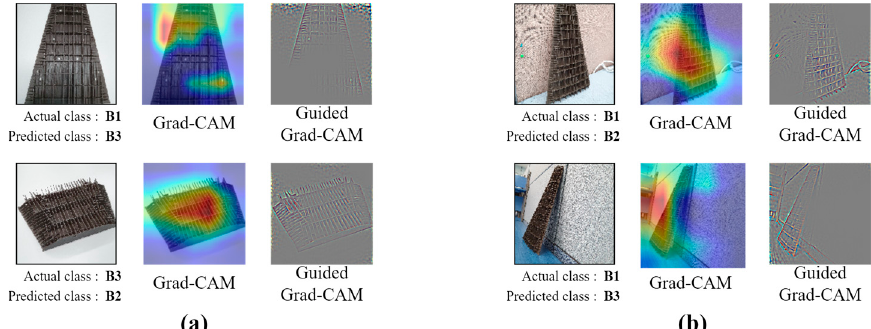
Figure 4. Grad-CAM and Guided Grad-CAM images for analyzing the causes of low prediction accuracy in an experimental environment using Non-Thr datasets: ( a ) Visualizing predicted result affected by similarity in the Non-Thr densenet-201 2 experimental envorinment; ( b ) Visualizing predicted result affected by background noise in the Non-Thr densenet-201 2 experimental environment.